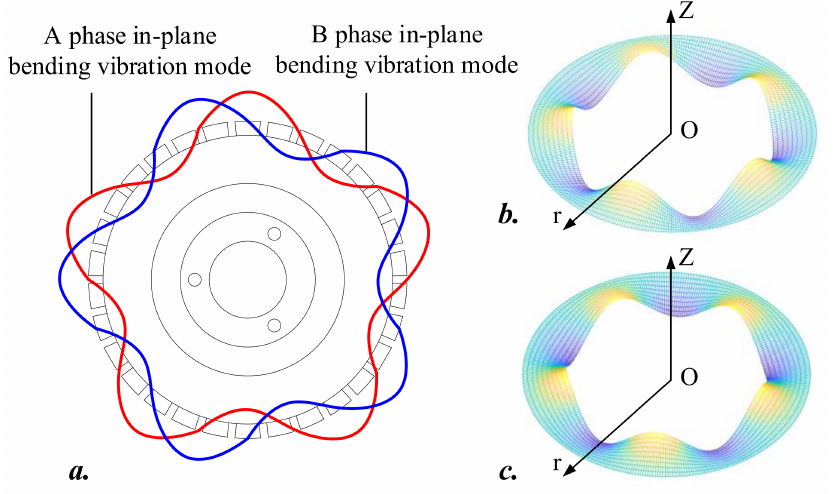
Figure 3. Operating modes of the motor: ( a ) in-plane B 05 bending vibration modes; ( b ) A phase